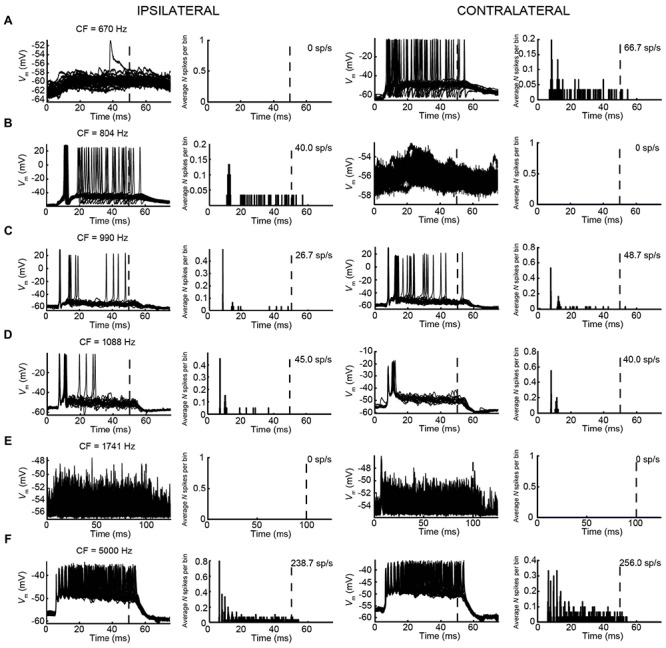
Responses of mLNTB neurons to short tones at CF.
Vm (left) and PSTH (right) of responses to ipsilateral (two leftmost columns) and contralateral (two rightmost columns) short tones at CF for 6 mLNTB neurons. Bin size = 0.1 ms. Spike rate is indicated for each response. (A) 80 dB SPL/30 repetitions; (B) 85 dB SPL/30 repetitions; (C) 80 dB SPL/30 repetitions; (D) 70 dB SPL/20 repetitions; (E) 70 dB SPL/50 repetitions; (F) 70 dB SPL/30 repetitions.